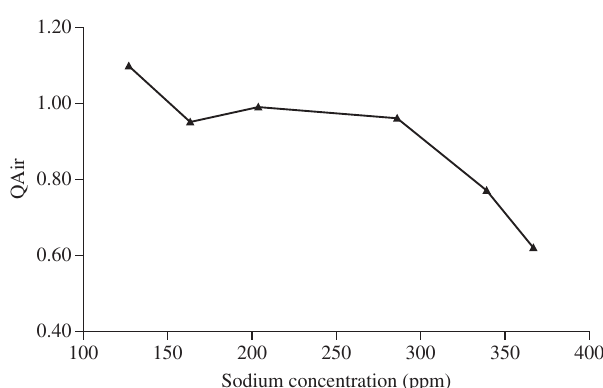
Figure 4. Quality figure to the air (Q tration